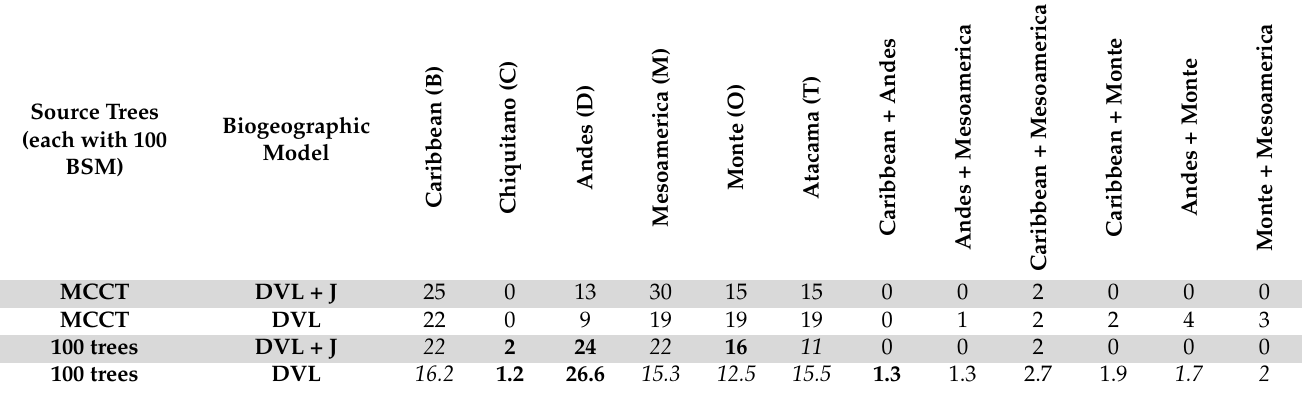
Table 1. Geographic range of origin of clades dispersing into the Caatinga and their relative frequencies (in %) in different biogeographic stochastic maps. Taking topological uncertainty into account (by running stochastic maps in 100 posterior trees) increases the percentage of inferences of dispersal coming from Andean or Chiquitano dry forests (values marked in bold) while decreasing the probability of dispersal coming from Mesoamerican or Caribbean dry forests, or the Atacama desert (values marked in